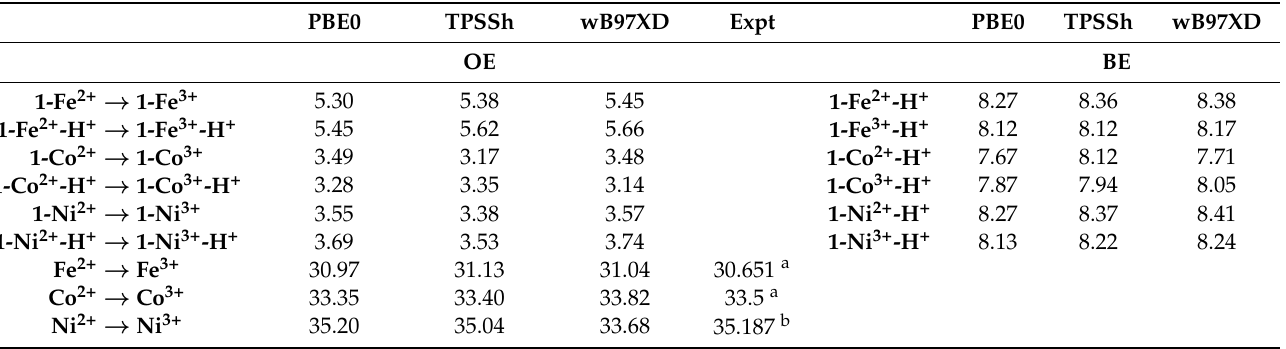
Table 2. Oxidation Energy M 2+ → M 3+ (OE in eV) in the Calculated Complexes, in eV, and Binding energy of H + (BE in eV) in THF solvent, see Scheme 1. PBE0